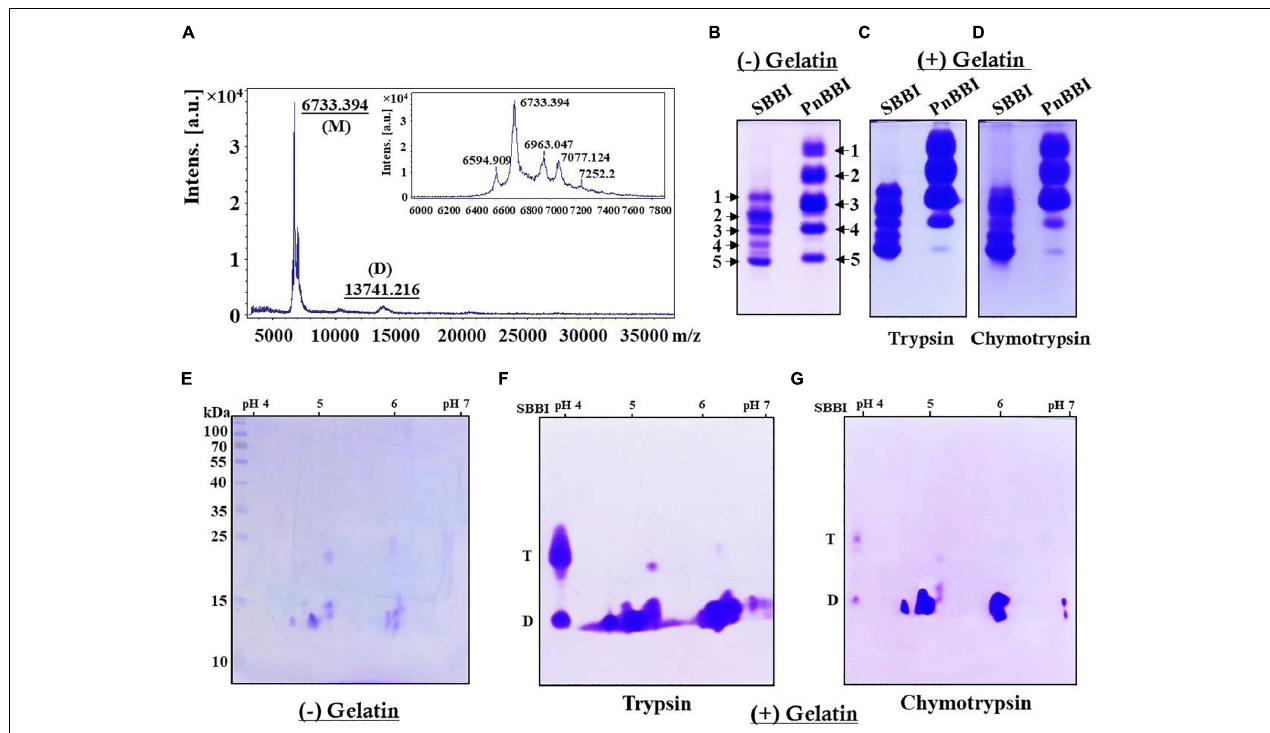
FIGURE 2 | Molecular mass determination and electrophoretic visualization of PnBBI isoinhibitors, and in-gel activity staining. (A) MALDI-TOF intact mass spectrum of PnBBI from 3000-37000 m/z representing a sharp and high-intensity peak (monomer) with a molecular mass of 6733.394 Da, and its self-associated dimer (13741.216 Da). Inset: zoomed spectrum at 6000-7800 m/z represents the peanut isoinhibitors; (B) Visualization of PnBBI isoinhibitors (20 µ g) resolved on native gel electrophoresis (12.5%). In-gel activity staining against bovine (C) trypsin and (D) chymotrypsin resolved on gelatin Native-PAGE; (E) 2-D electrophoretic separation of PnBBI (70 µ g) isoinhibitors (IEF, pH 4-7, 11 cm, L) under non-reducing conditions and respective in-gel activity staining against bovine (F) trypsin and (G) chymotrypsin. The second dimension was performed on SDS-PAGE (15%) under non-reducing conditions. Gels were stained with CBB R-250. Soybean BBI (SBBI) is loaded as a positive control in Native-PAGE as well as activity staining studies. D-dimer and T-tetramer. The mass spectrum and gel pictures shown here are the selective representatives of two or three biological replicates (data provided as Supplementary Data Sheet 3